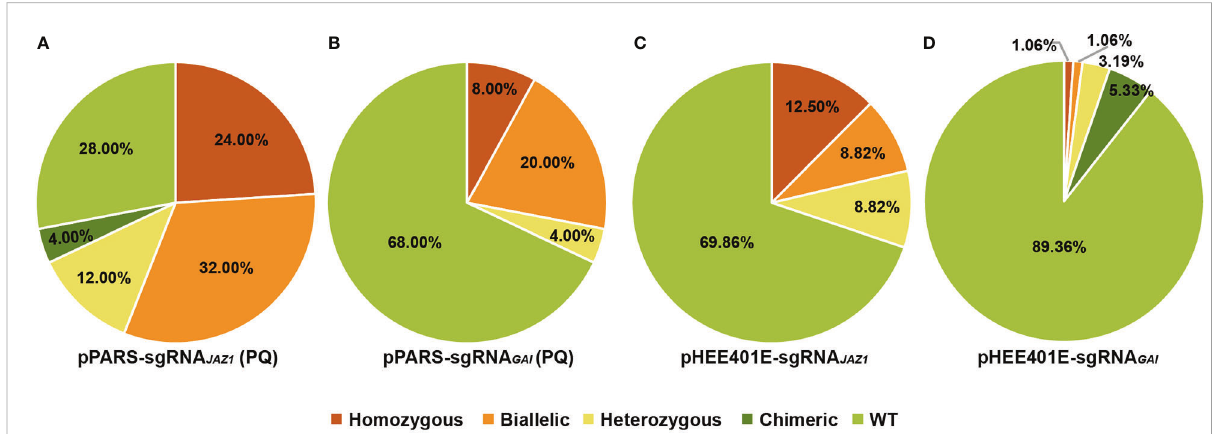
FIGURE 4 Mutation type and frequency at target sites with or without PARS. (A) Percentages of WT and different types of mutations at JAZ1 loci selected using PARS on paraquat (PQ) plates. (B) Percentages of WT and different types of mutations at GAI loci selected using PARS on paraquat (PQ) plates. (C) Percentages of WT and different types of mutations at JAZ1 loci using the original system (pHEE401E). (D) Percentages of WT and different types of mutations at GAI loci using the original system